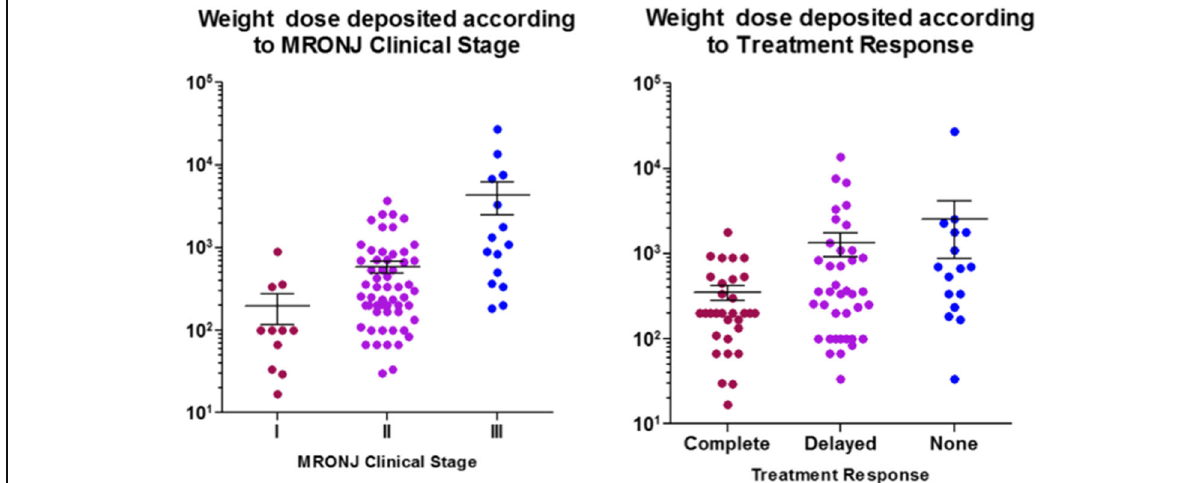
Fig. 1 Weight dose deposited according to MRONJ Clinical Stage and Treatment Response. Actual weight dose deposited were calculated and the values were awarded